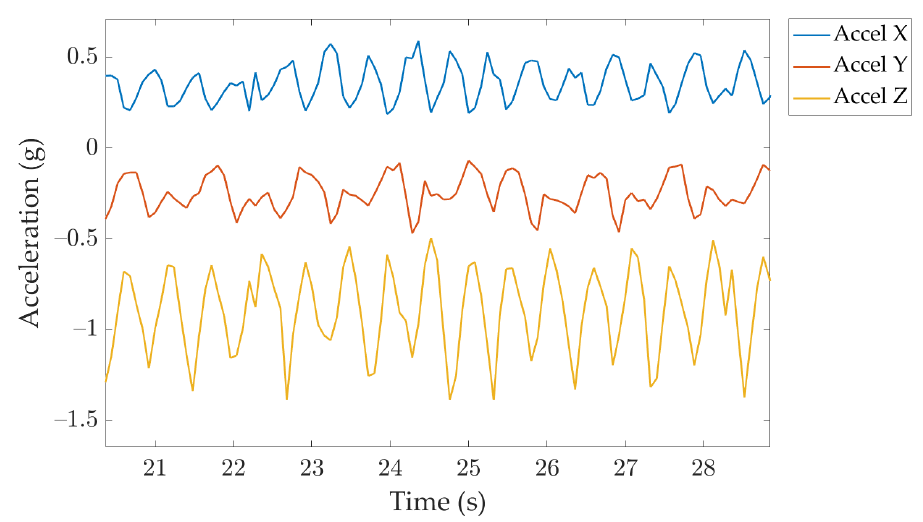
Figure 12. Continuous movement streaming using FSK in farm (100 m range).